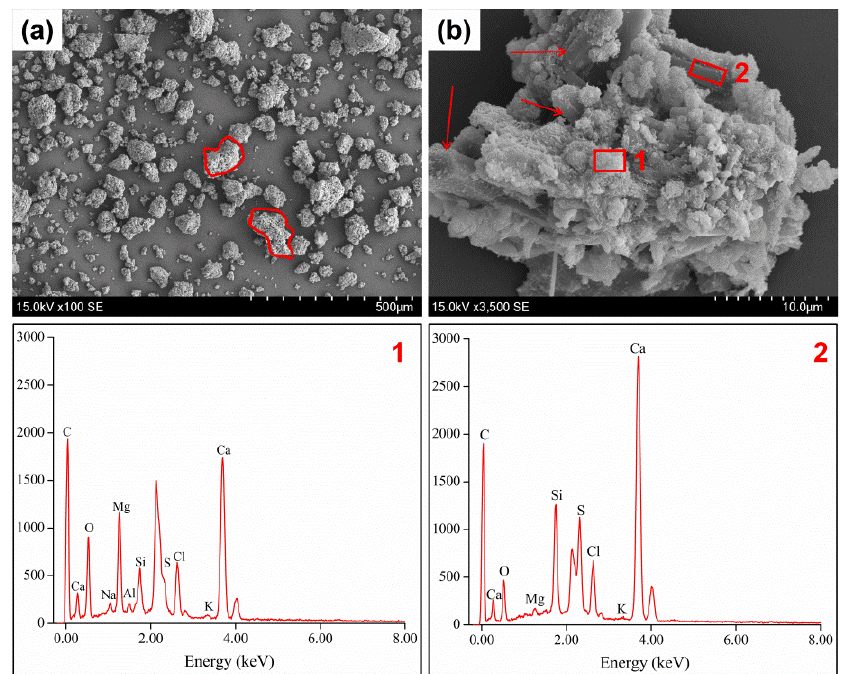
Figure 4. SEM and EDS images of FA900-10: ( a ) low-magnification image; ( b ) high-magnification image.